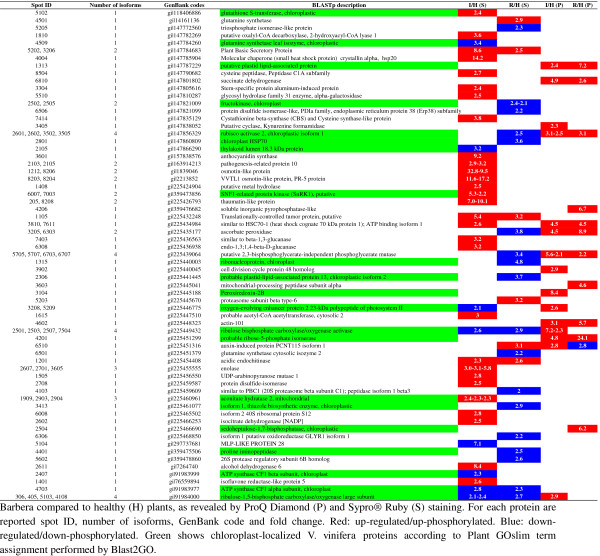
Differentially expressed/phosphorylated proteins in phytoplasma-infected (I) and recovered (R) grapevines in comparison to healthy (H) ones. Differentially expressed proteins (S) have been revealed by Sypro® Ruby stain and differentially phosphorylated proteins (P) have been revealed by ProQ Diamond stain. For each protein spot ID, number of isoforms, GenBank code and fold change are reported. Red: up-regulated/up-phosphorylated. Blue: down-regulated/down-phosphorylated. Green shows chloroplast-localized V. vinifera proteins according to Plant GOslim term assignment performed by Blast2GO.